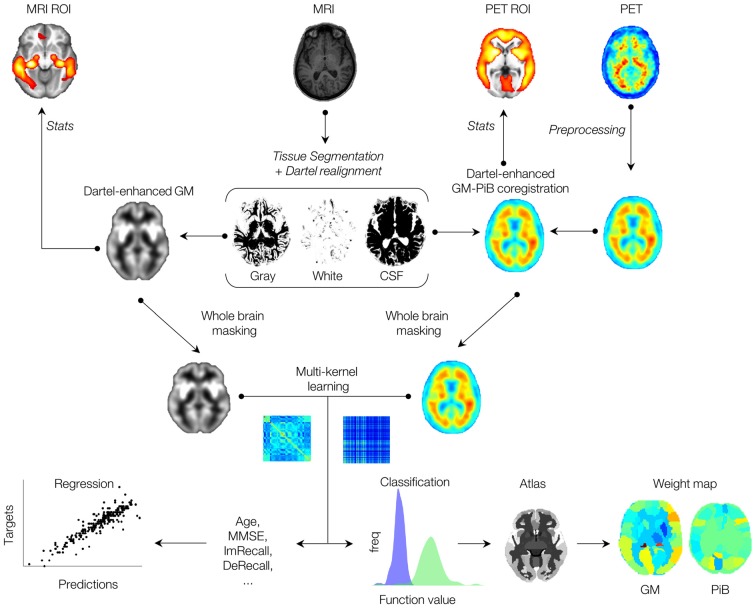
Schematic overview of the proposed multimodal (imaging) machine-learning framework. See text for detailed descriptions.